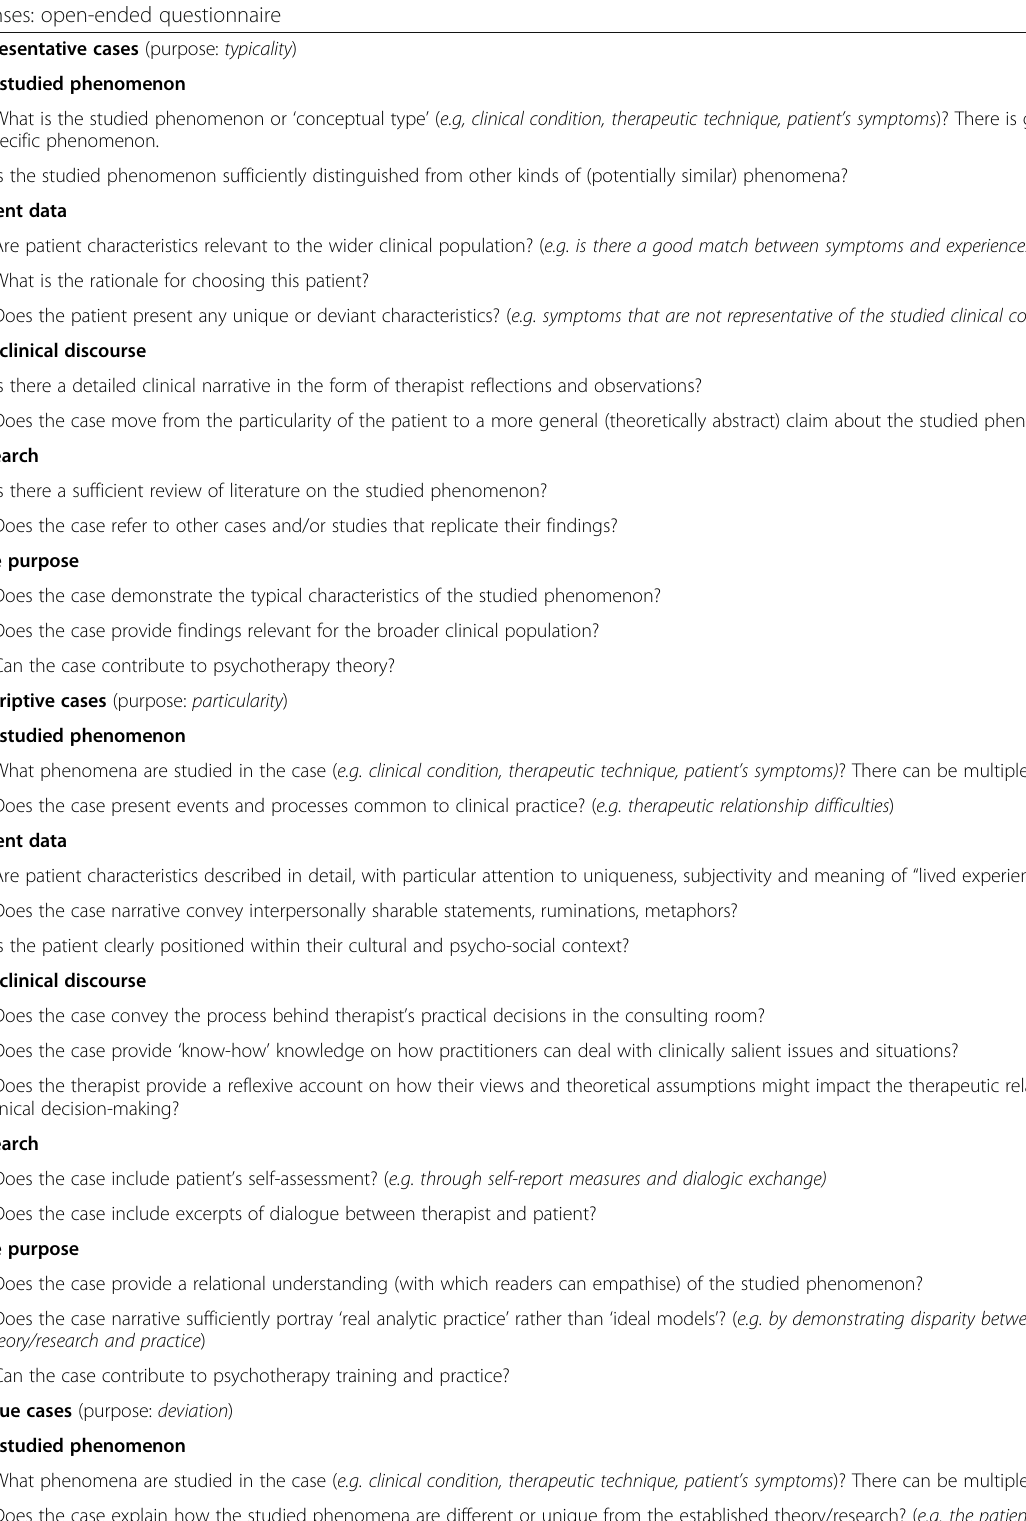
Table 13 Case Study Evaluation-tool (CaSE) purpose-based evaluative framework for systematic case studies.